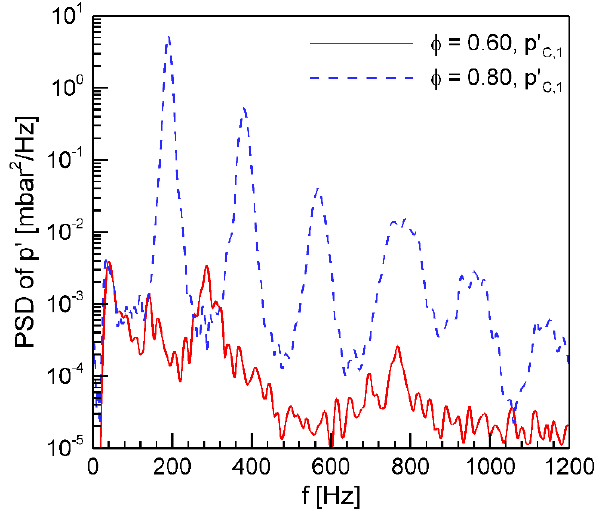
Figure 3. Power spectral densities corresponding to the cases in Figure 2.